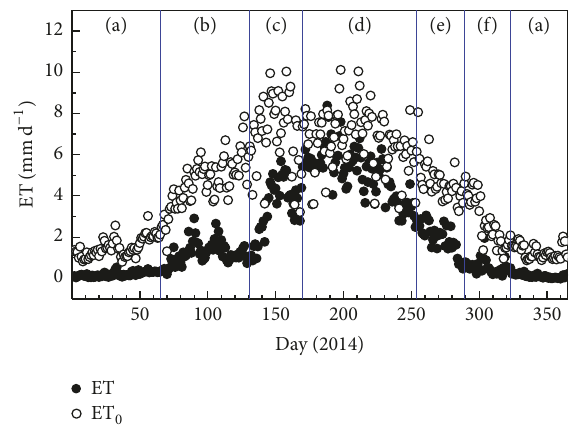
Figure 6: The daily evapotranspiration (ET) and daily reference evapotranspiration (ET 0 ) in the following periods: (a) the soil- frozen period; (b) the soil ablation period; (c) the germination, flowering, and leaf expansion period; (d) the vibrant growing season; (e) the leaf senescence period; and (f) the early soil-frozen period.